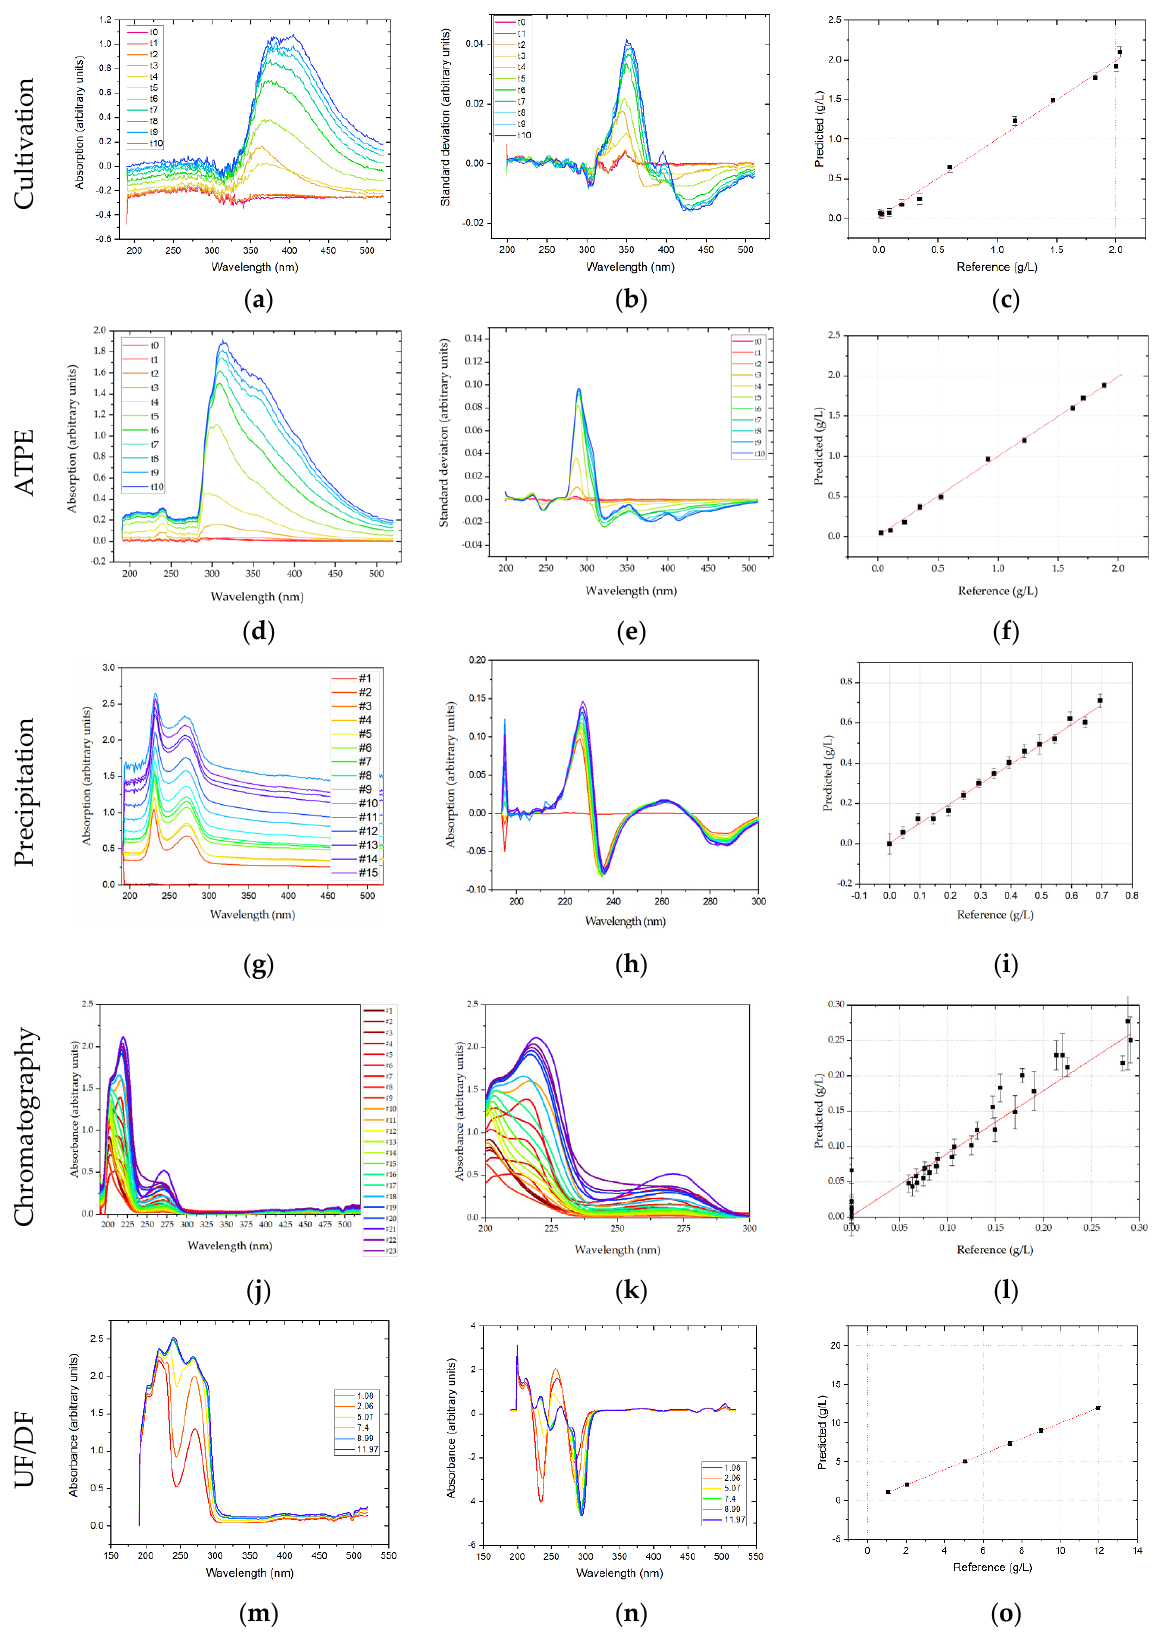
Figure 10. DAD spectra: raw ( a , d , g , j , m ), after preprocessing ( b , e , h , k , n ) and PLSR results ( c , f , i , l , o ). Spectra are color-coded from high concentration (blue) to low concentration (red).